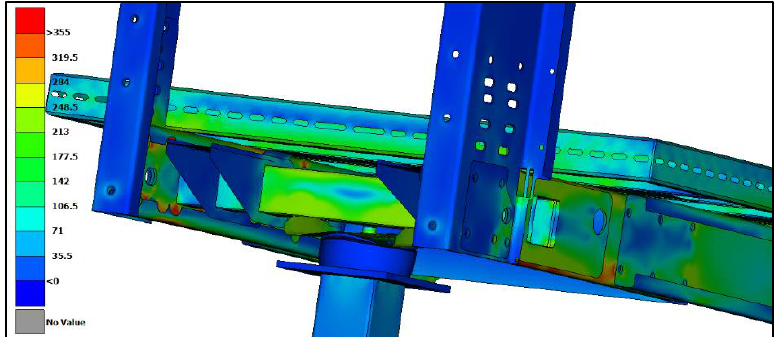
Figure 15. Von-Mises stress distribution on new-design elevator chassis for 10 mm settlement plate thickness. Elastic deformation of the settlement plate not touching suspending beam.